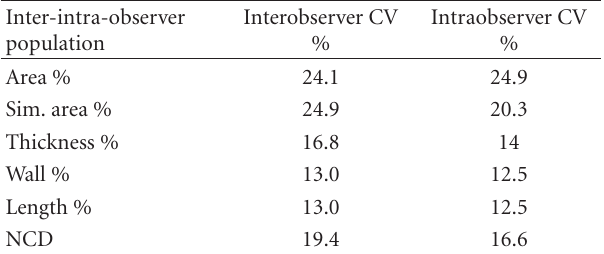
Table 2: The inter- and intraobserver mean coe ffi cients of variation for the AAC markers based on the inter-intra-observer test popula-